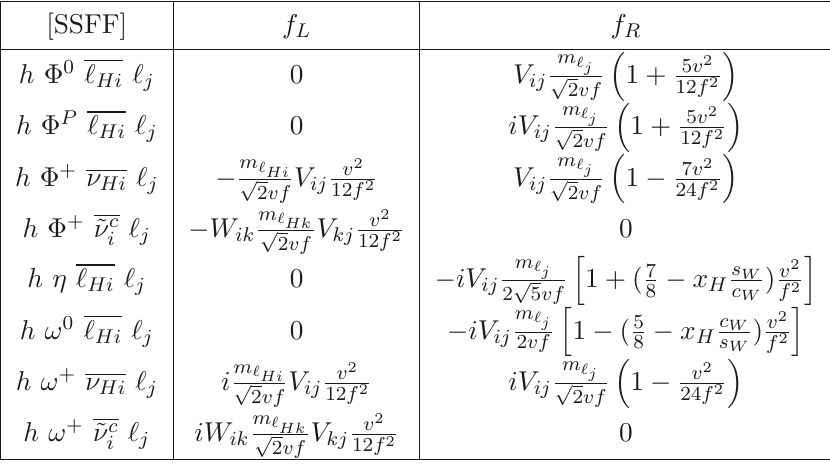
Table 4 . Scalar-Scalar-Fermion-Fermion couplings at